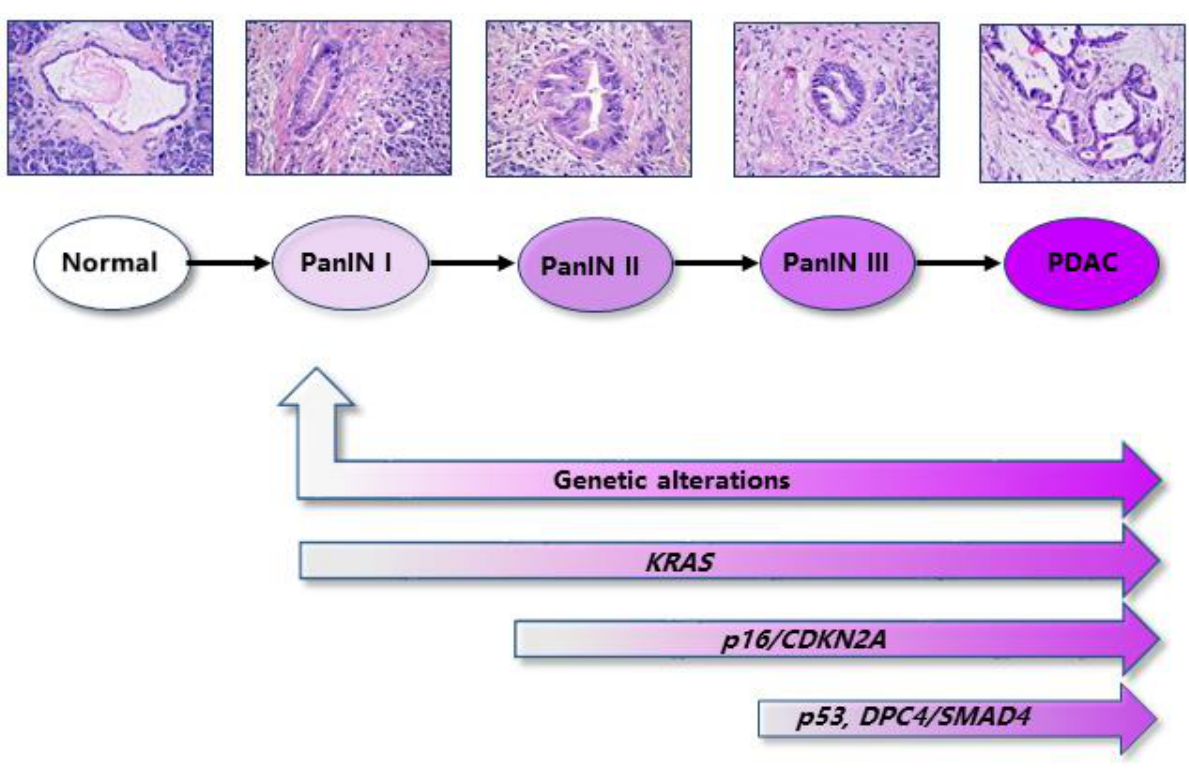
FIGURE 1: The pathological stages and dysregulated molecular events in PDAC development. The PDAC development process is catego- rized into pre-cancerous lesion (pancreatic intraepithelial neoplasia, PanINs) and malignant PDAC according to the pathological grade. Sim- ultaneously, aberrant genetic alterations occurre at different stages of PDAC development, including activating mutations of KRAS and inac- tivation mutations of tumor suppressors, like p16/CDKN2A, p53 , and DPC4/SMAD4